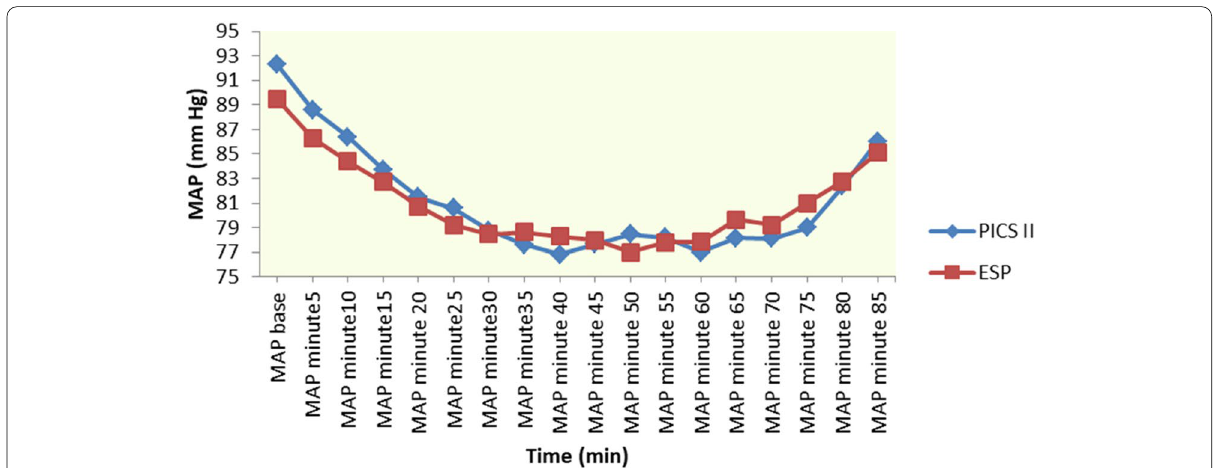
Fig. 3 The mean arterial blood pressure (MAP) throughout the operation time in both the study groups (no significant difference, P >